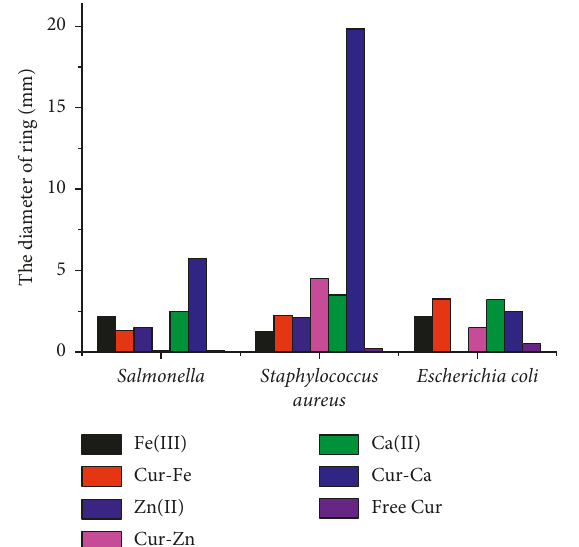
Figure 9: Antimicrobial activity of curcumin metal ion complexes and free curcumin at the concentration of 100 μ